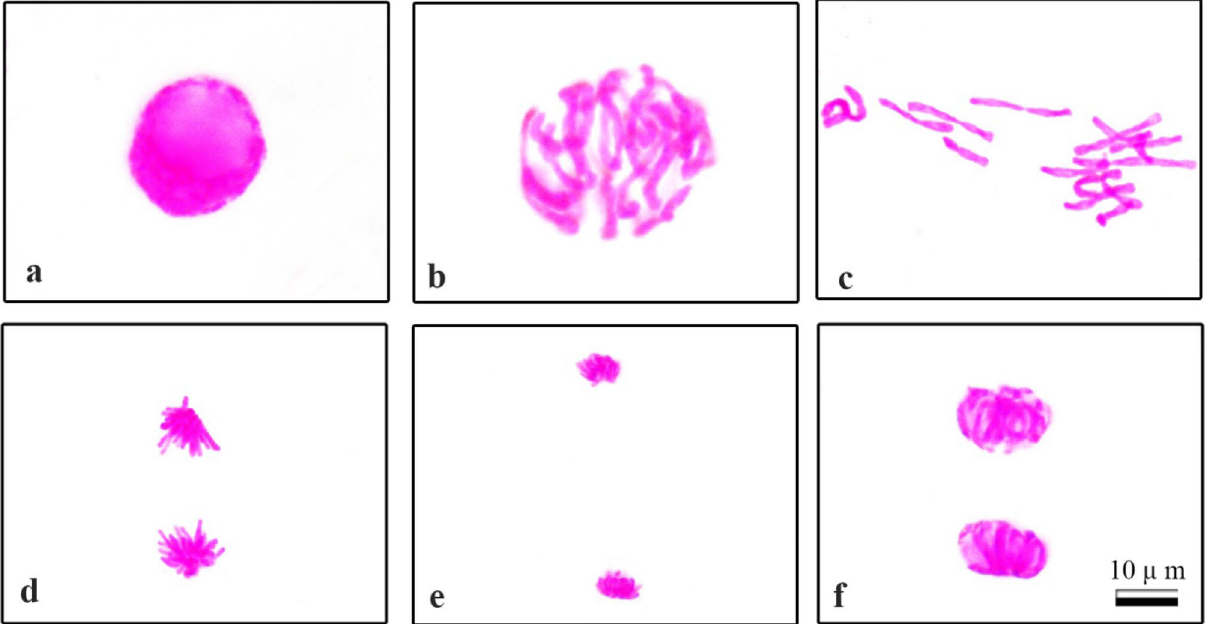
Figure 5. Normal mitosis phases in the roots meristem cells of Allium cepa L. grown in tap water and 0.01 µM COR medium ( a ) interphase, ( b ) prophase, ( c ) metaphase, 2n = 16 chromosomes, ( d ) anaphase, ( e ) late anaphase, ( f ) telophase. Scale bar 10